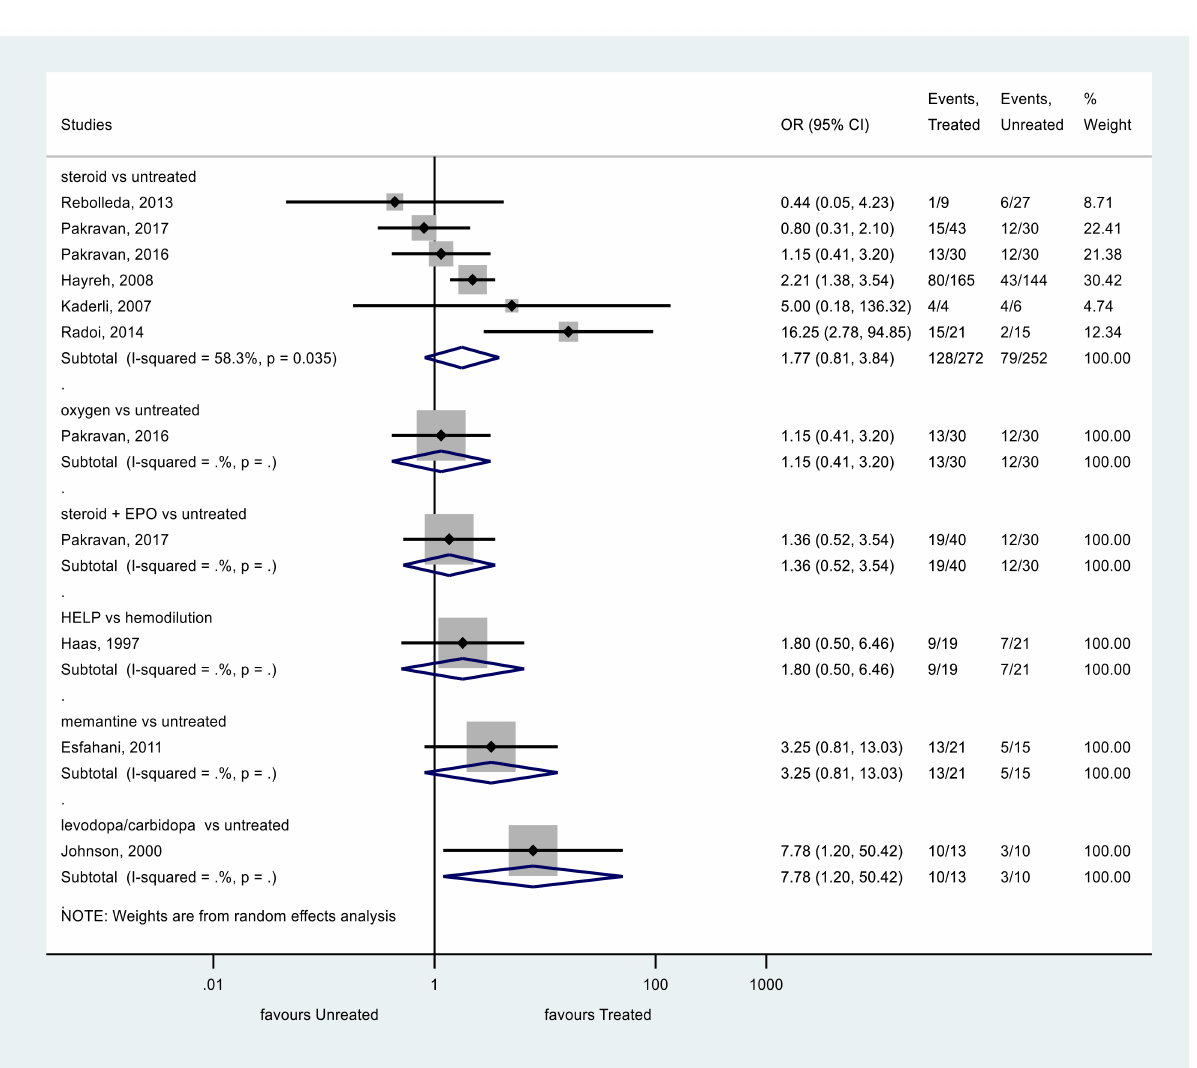
Figure 3. Comparison of interventions to no treatment regarding visual acuity (as a categorical